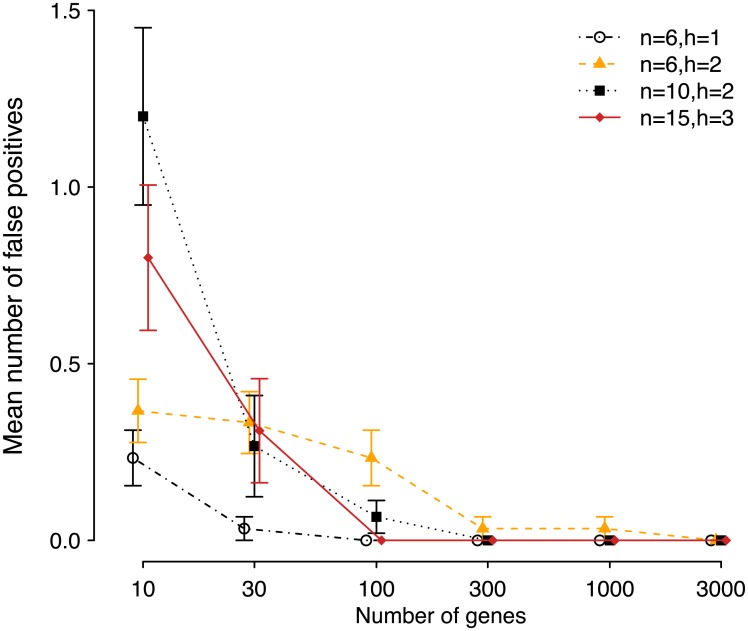
Accuracy of SNaQ to recover the major tree in the species network, from sequence alignments.The major tree is obtained by suppressing all minor hybrid edges (γ < 0.5) to capture the major vertical inheritance pattern. Accuracy is measured as half the Robinson-Foulds distance between the true and estimated tree, i.e. the number of incorrect edges in the estimated tree. A lot fewer genes are needed to accurately estimate the major vertical pattern, compared to the horizontal pattern.